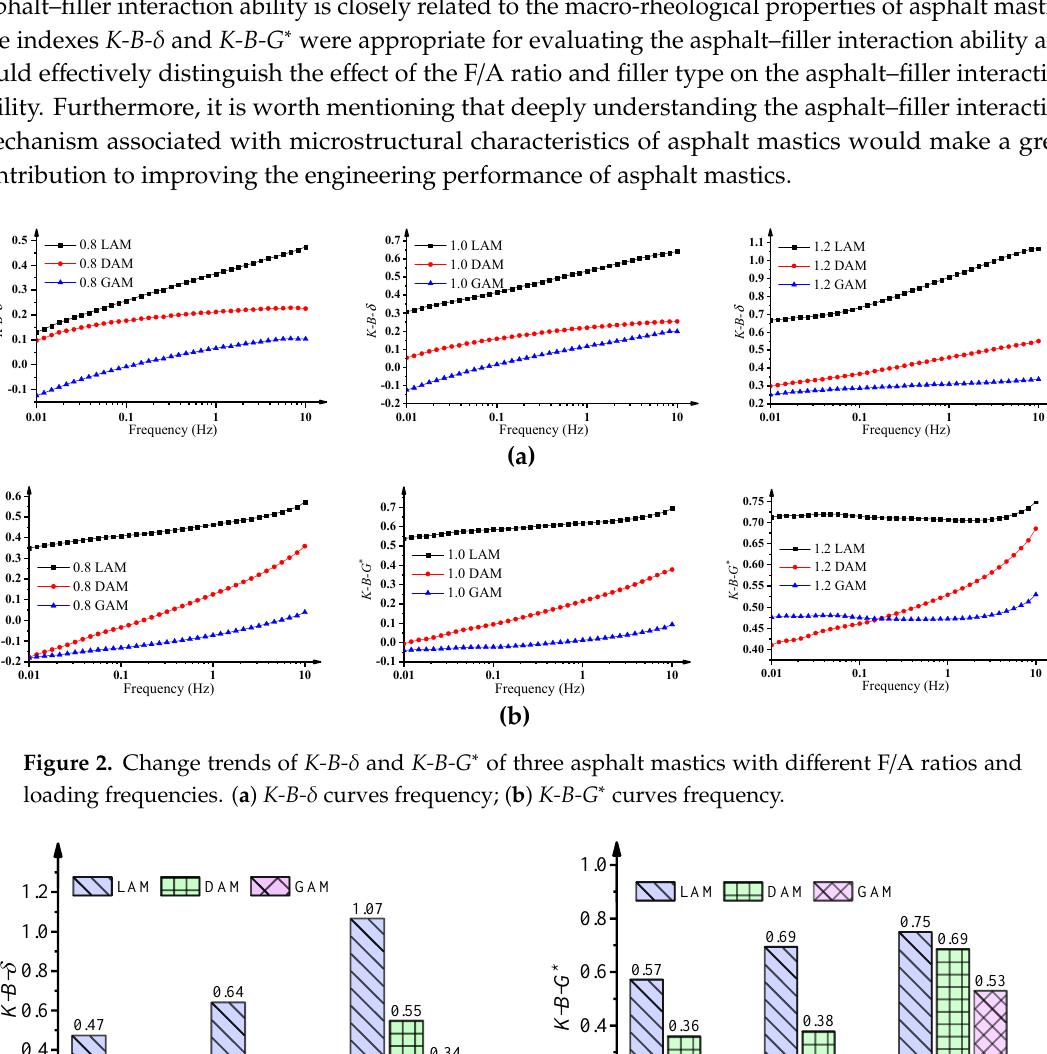
( b ) Figure 1. Frequency sweep curves for the base asphalt binder and asphalt mastics. LAM: limestone asphalt mastic, DAM: diabase asphalt mastic, GAM: granite asphalt mastic. ( a ) |𝐺 ∗ | versus frequency ; ( b ) 𝛿 versus frequency . Based on the results of |𝐺 ∗ | and 𝛿 , the change curves of K-B- 𝛿 and K-B- 𝐺 ∗ for the three asphalt mastics over the full frequency range are shown in Figure 2. The results indicate that the values of K- B- 𝛿 and K-B- 𝐺 ∗ presented an increasing trend with the increase of loading frequency, demonstrating that the asphalt–filler interaction ability is susceptible to loading frequencies. The maximum values of K-B- 𝛿 and K-B- 𝐺 ∗ occurred at the frequency of 10 Hz; the maximum values of K-B- 𝛿 and K-B- 𝐺 ∗